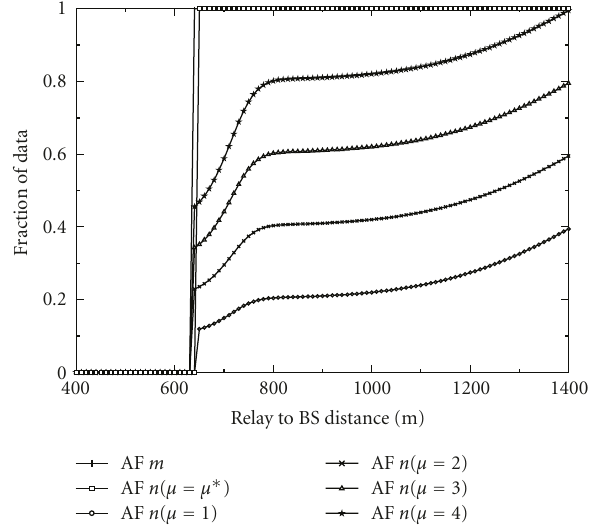
Figure 10: Fraction of cooperation data versus di ff erent locations of the relay under AF forwarding.